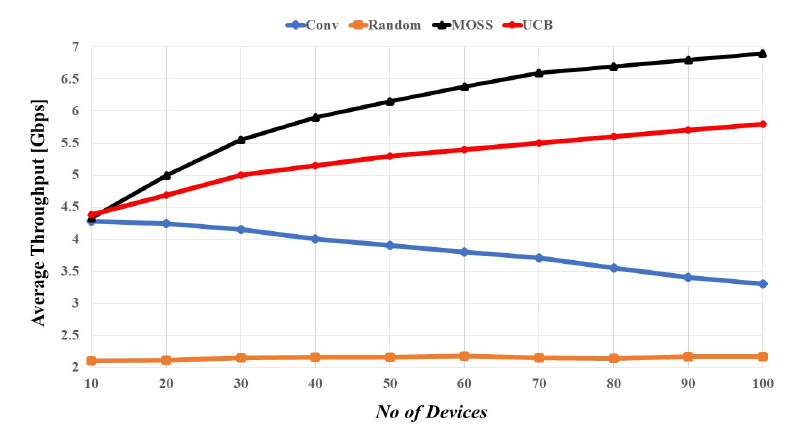
Figure 5. Average Throughput comparisons at no blockage.